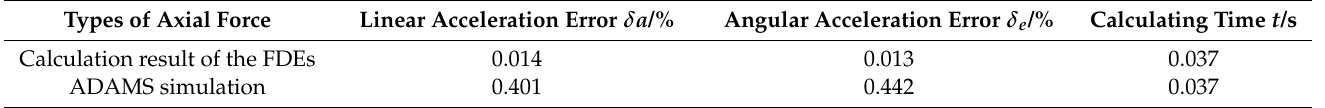
Figure 8. Numerical simulation error: ( a ) linear acceleration measurement error; ( b ) angular acceleration measurement error. Table 1. The solution result of the IDEs of the sensor.